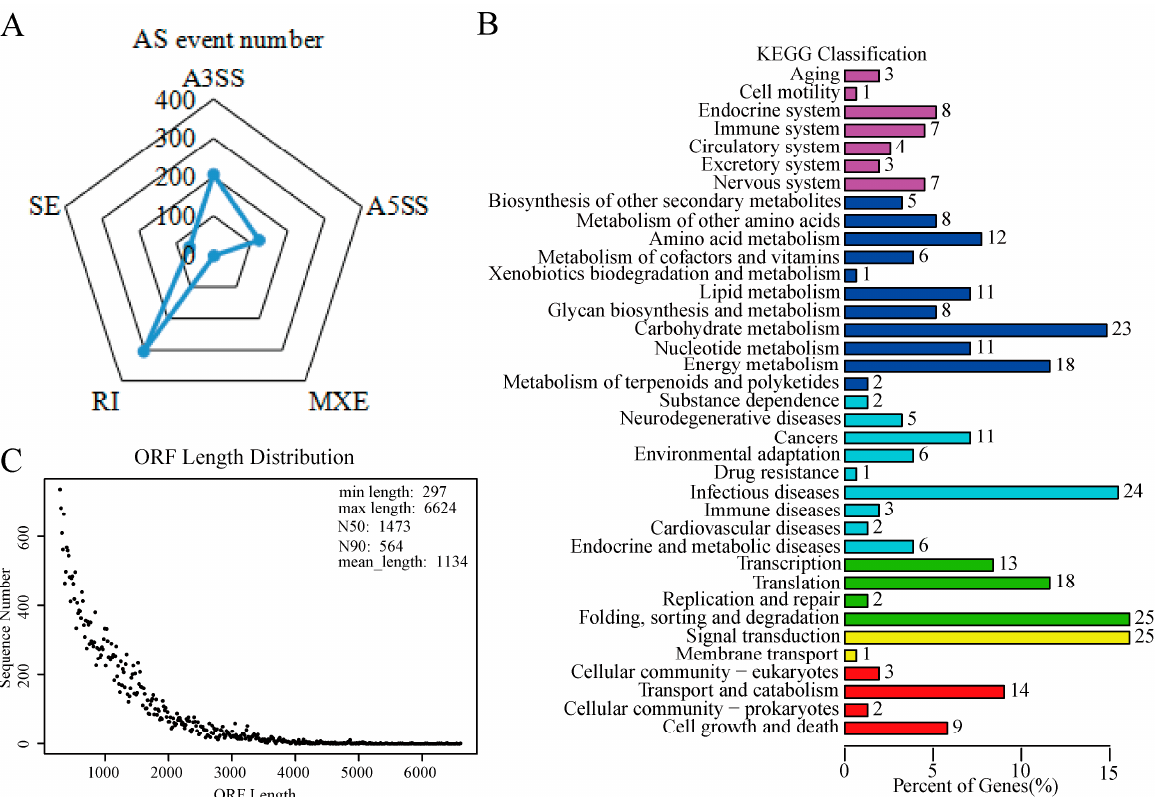
Figure 2. Alternative splicing (AS) identification and analysis, and open reading frame (ORF) prediction. ( A ) Statistics of the distinct AS events, ( B ) KEGG enrichment analysis of AS genes, and ( C ) length distribution of ORFs.